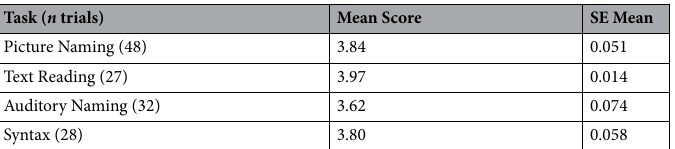
Table 2. Language testing. Tasks were delivered in a quiet clinical setting and matched on word frequency. Each stimulus was scored from 0 to 4 using guidelines provided by the Quick Aphasia Battery.